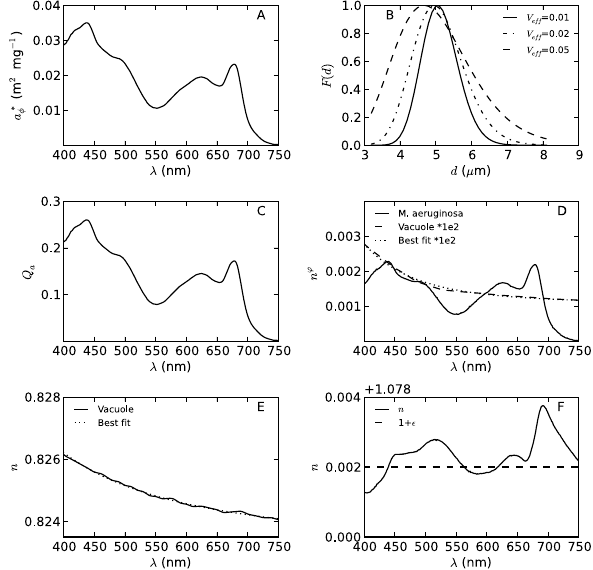
Fig. 1. Optical and size parameters for M. aeruginosa and gas vac- uole. (A) Chl a -specific absorption, (B) normalised log-normal size distribution function, F(d) , for V eff =0.01, 0.02, and 0.05; (C) ex- perimental absorption efficiency factor; (D) n 0 for M. aeruginosa and gas vacuole × 1 e 2 , showing best-fit line; (E) n for gas vacuole showing best-fit line; and (F) n for M. aeruginosa showing 1 + (cid:15)